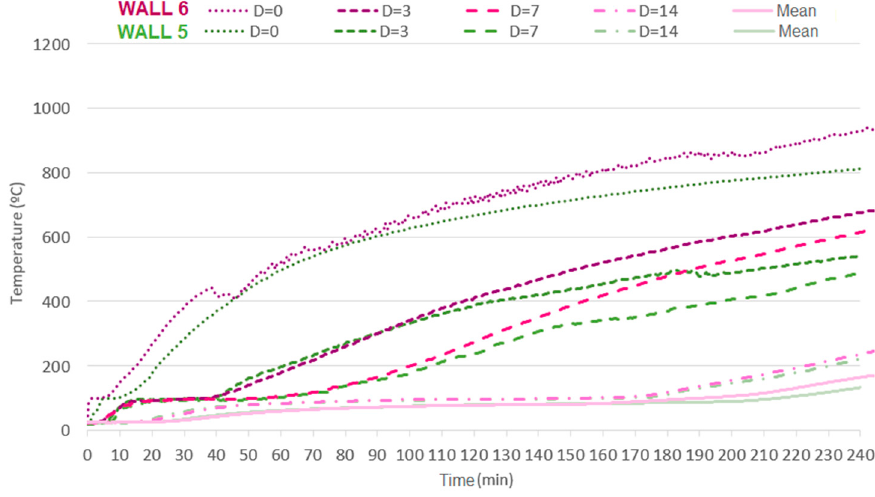
Figure 22. Influence of loading on masonries with 25 mm of coating on the fire-exposed face.